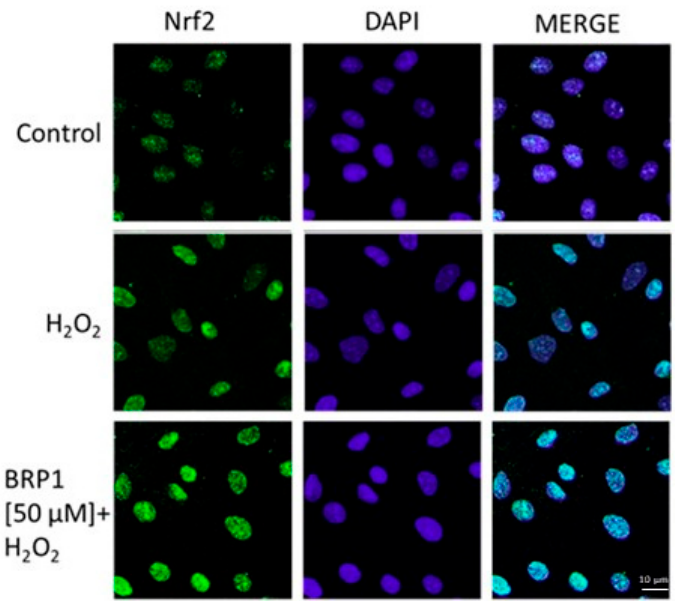
Figure 4. Effect of BRP (50 μ M) on Nrf2 nuclear translocation, evaluated using immunofluorescence assay confocal microscopy. Scale bar: 10 μ m. Blue and green fluorescence indicate the localization of nucleus (DAPI) and Nrf2, respectively.